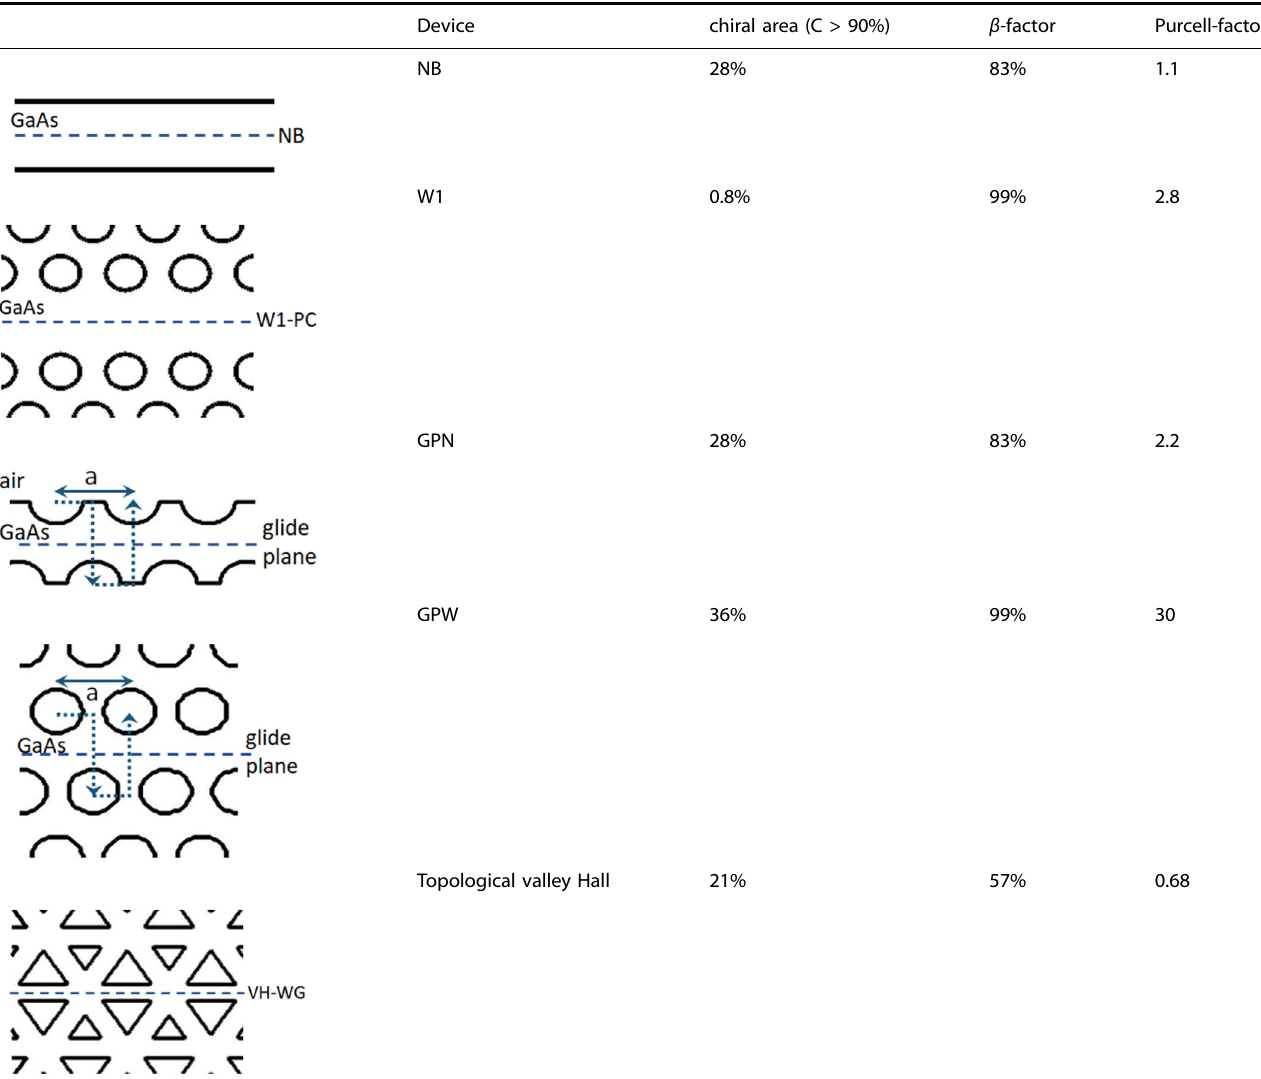
Table 1. Comparison of chiral quantum optical waveguide systems including nanobeam (NB), W1-PC, glide-plane nanobeam (GPN), glide-plane waveguide (GPW), and topological Valley-Hall